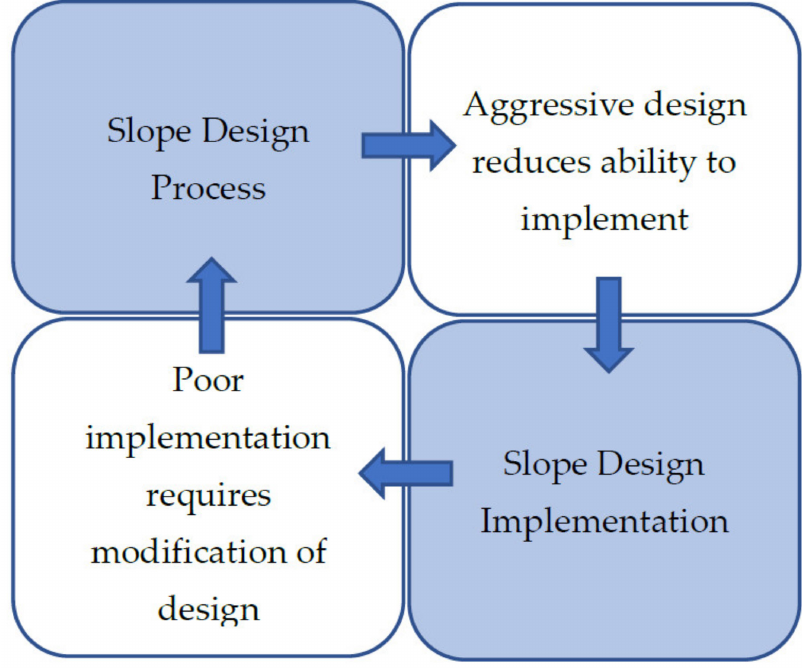
Figure 1. A 2 × 2 interaction